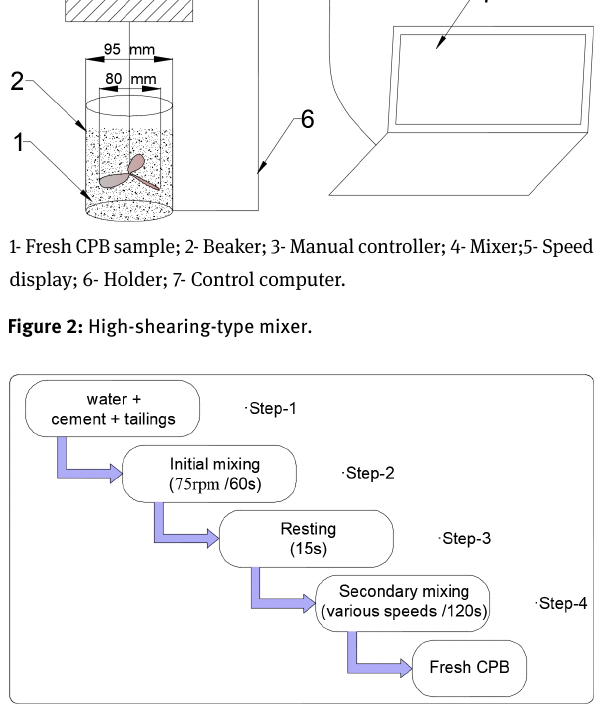
Figure 3: Mixing protocol to prepare CPB; Shear rates for Step-4 were 120, 240, 360, 480, 600, 720 s −1